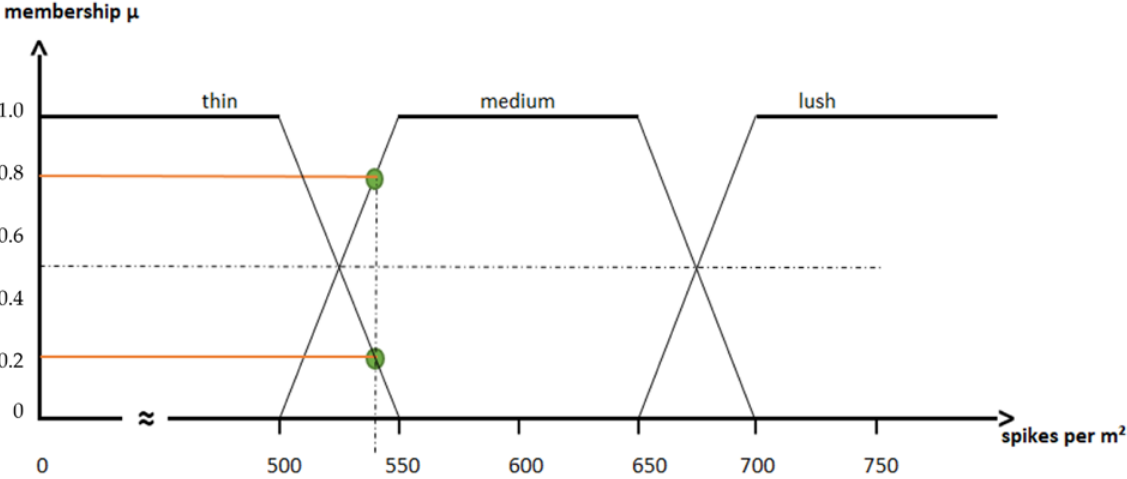
Figure 4. Fuzzy membership function using the example of the linguistic variable ‘crop